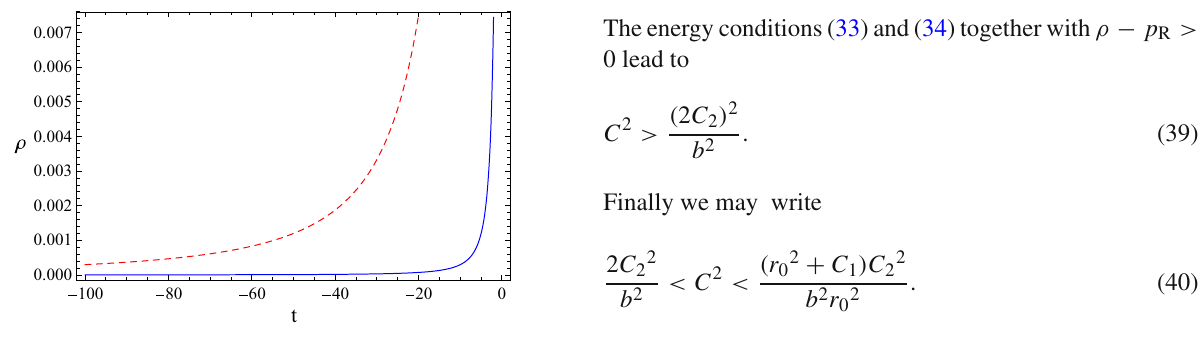
Fig. 1 Density as a function of time at the center (dashed line) and surface (solid line) of the star